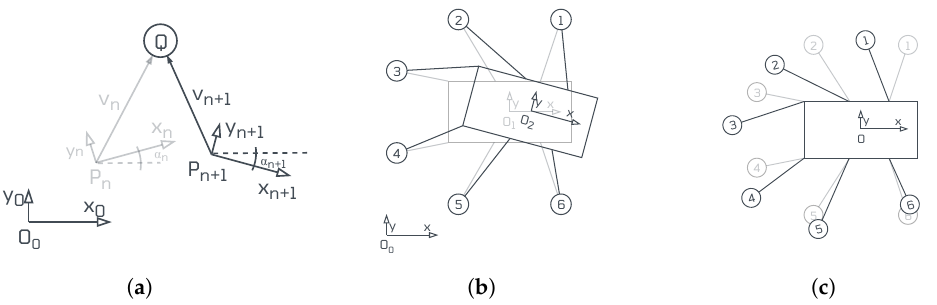
Figure 5. Comparison of the movement in the robot’s and world coordinates. ( a ) Representation of the reference change of the point Q between ( P n , R n ) and ( P n + 1 , R n + 1 ) , where α k represent the angle for the rotation matrix R k . ( b ) Comparison between the initial (light color) and final position in global coordinates. ( c ) Comparison between the initial (light color) and final position in the robot’s